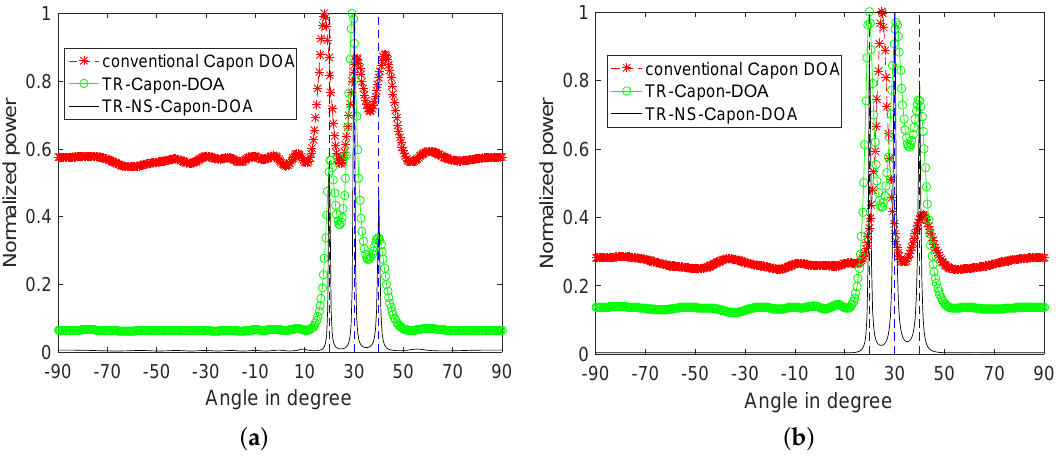
Figure 10. 3-path normalized power spectra versus angles for conventional Capon DOA, TR-Capon-DOA and TR-NS-Capon-DOA algorithms under the condition SNR = − 15 dB and ULA, ( a ) LFM ( b )